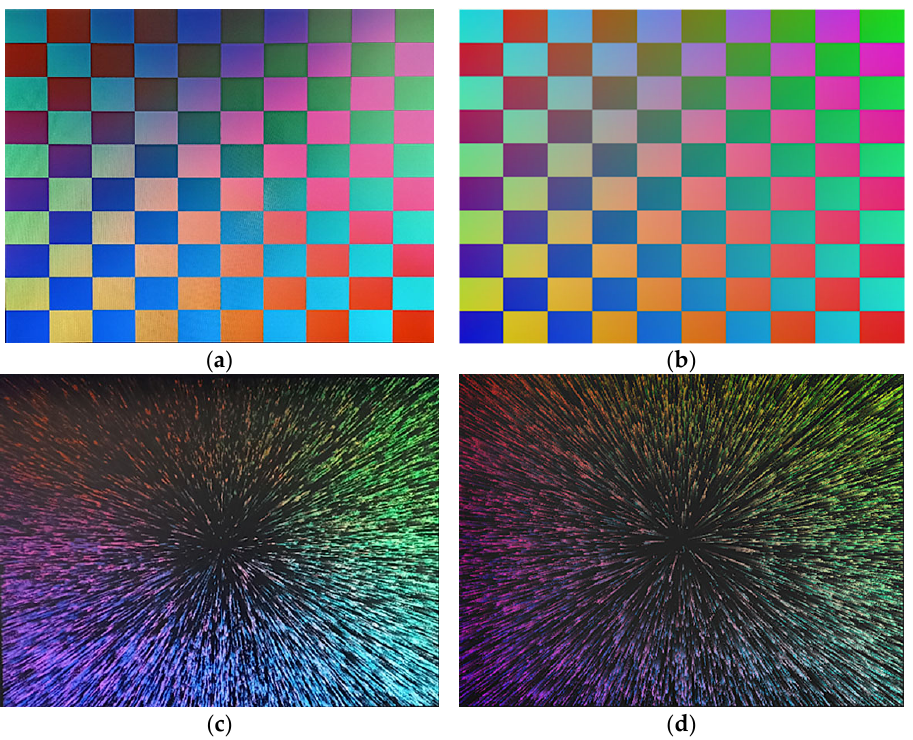
Figure 16. Results of unit tests ( a , b ) and functional tests ( c , d ) performed using RPILAB real device ( a , c ) and its virtual simulator ( b , d ): ( a ) photograph of real LCD during framebuffer test; ( b ) screenshot of virtual ‐ simulator framebuffer test; ( c ) photograph of real LCD for functional test using demo application; ( d ) screenshot of virtual ‐ simulator functional test using demo application.